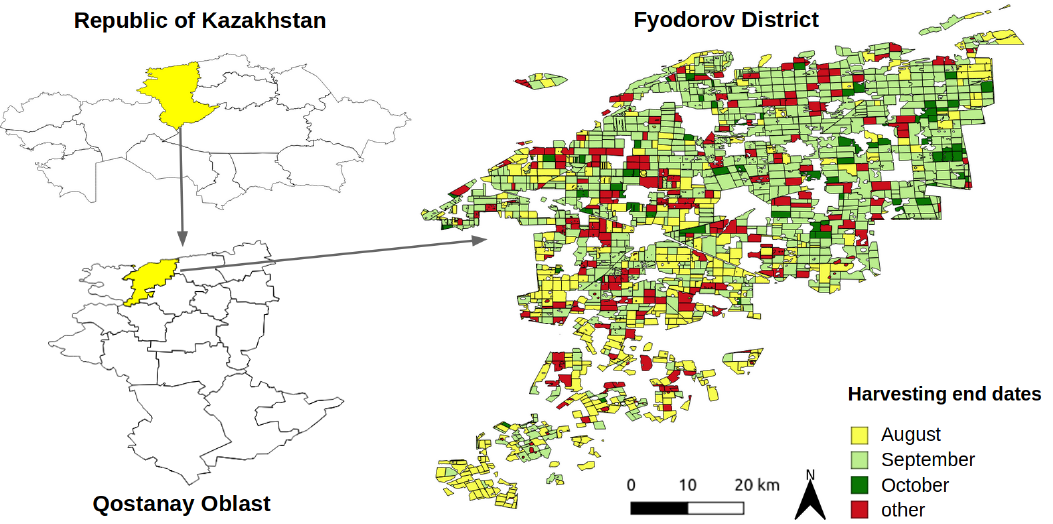
Figure 10. The cartogram of harvesting of areas in Fyodorov District of Qostanay Oblast (the Republic of Kazakhstan),